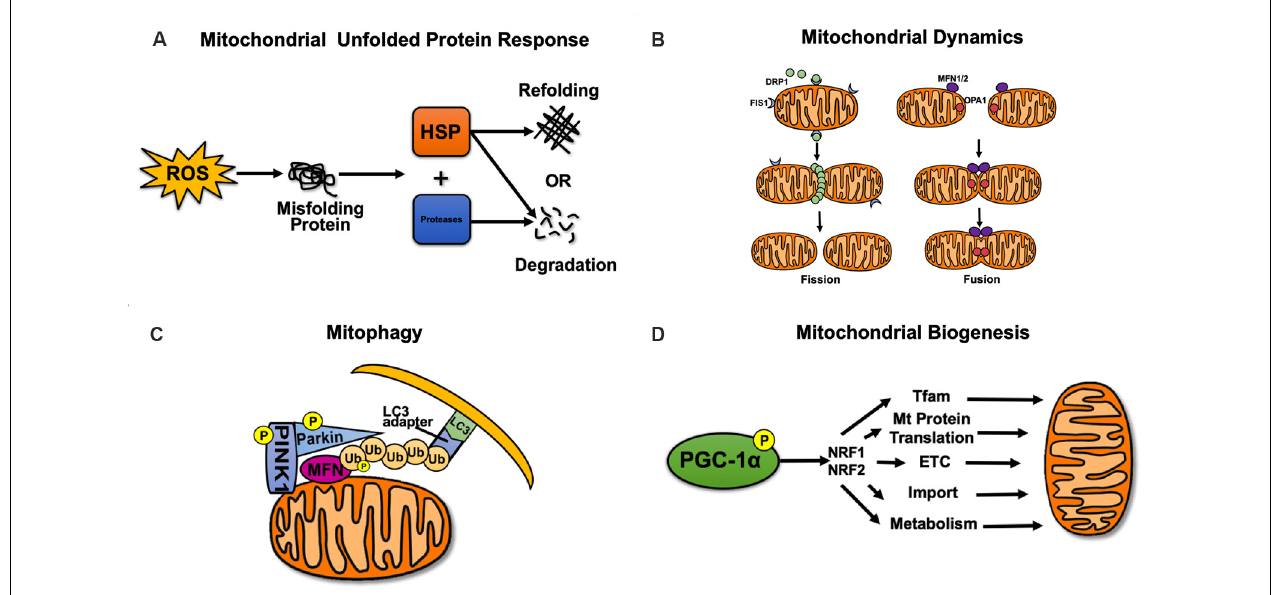
FIGURE 1 | Mitochondrial quality control. (A) Mitochondrial unfolded protein response. Refolding or degradation of mitochondrial misfolded/unfolded proteins is mainly mediated by molecular chaperones and proteolytic enzymes in the mitochondria. (B) Dynamic remodeling and repair of mitochondrial fission and fusion. Mitochondrial fission is regulated by dynamin-related GTPase (DRP1) and FIS1, while mitochondrial fusion is regulated by MFN1/2 and optic atrophy 1 (OPA1). (C) Mitophagy. The PINK1–Parkin-mediated mitophagy pathway can mediate the formation of autophagosomes. (D) Mitochondrial biogenesis. Mitochondrial biogenesis is mainly regulated by PGC-1 α and nuclear respiratory factors 1 and 2